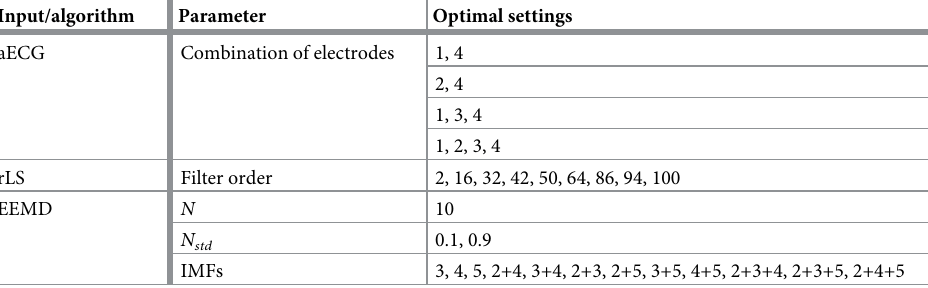
Table 11. Selection of the optimal parameters of the method